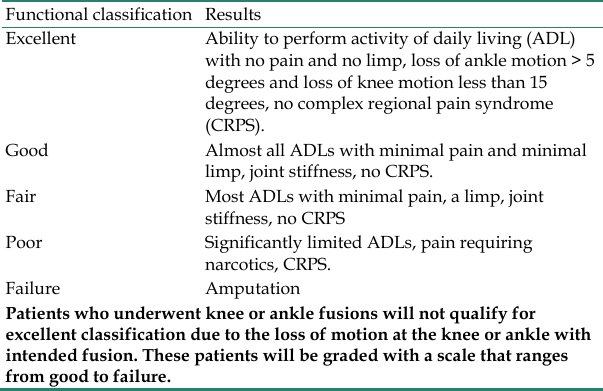
Table 1. Functional ASAMI scoring Functional classification Results